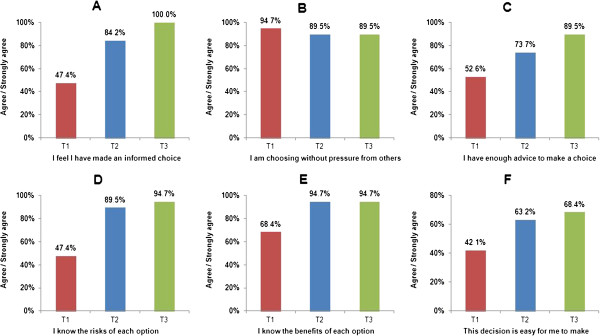
Trends relating to decisional conflict individual items. (A) I feel I have made an informed choice. (B) I am choosing without pressure from others. (C) I have enough advice to make a choice. (D) I know the risks of each option. (E) I know the benefits of each option. (F) This decision is easy for me to make.